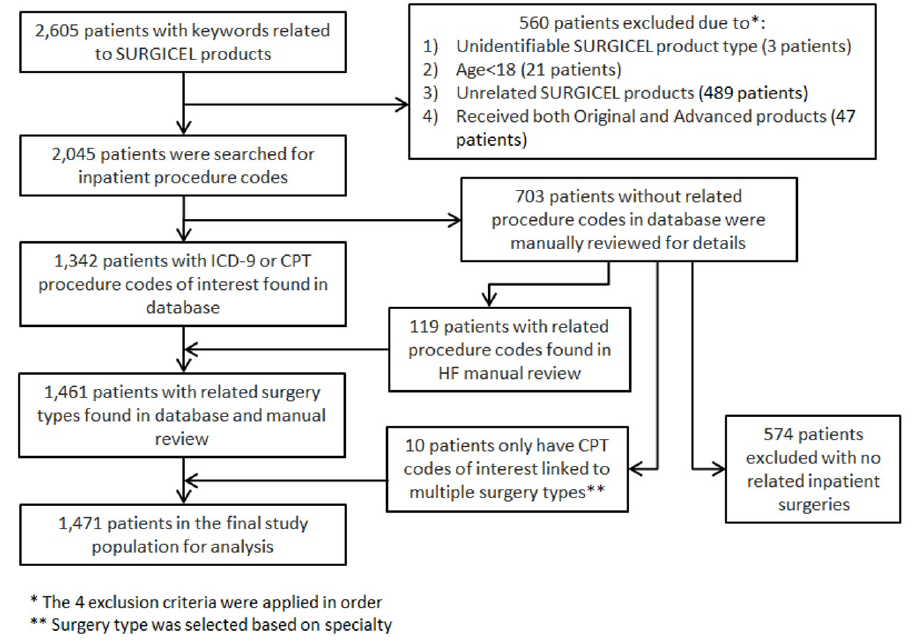
Figure 1: Flowchart of study population